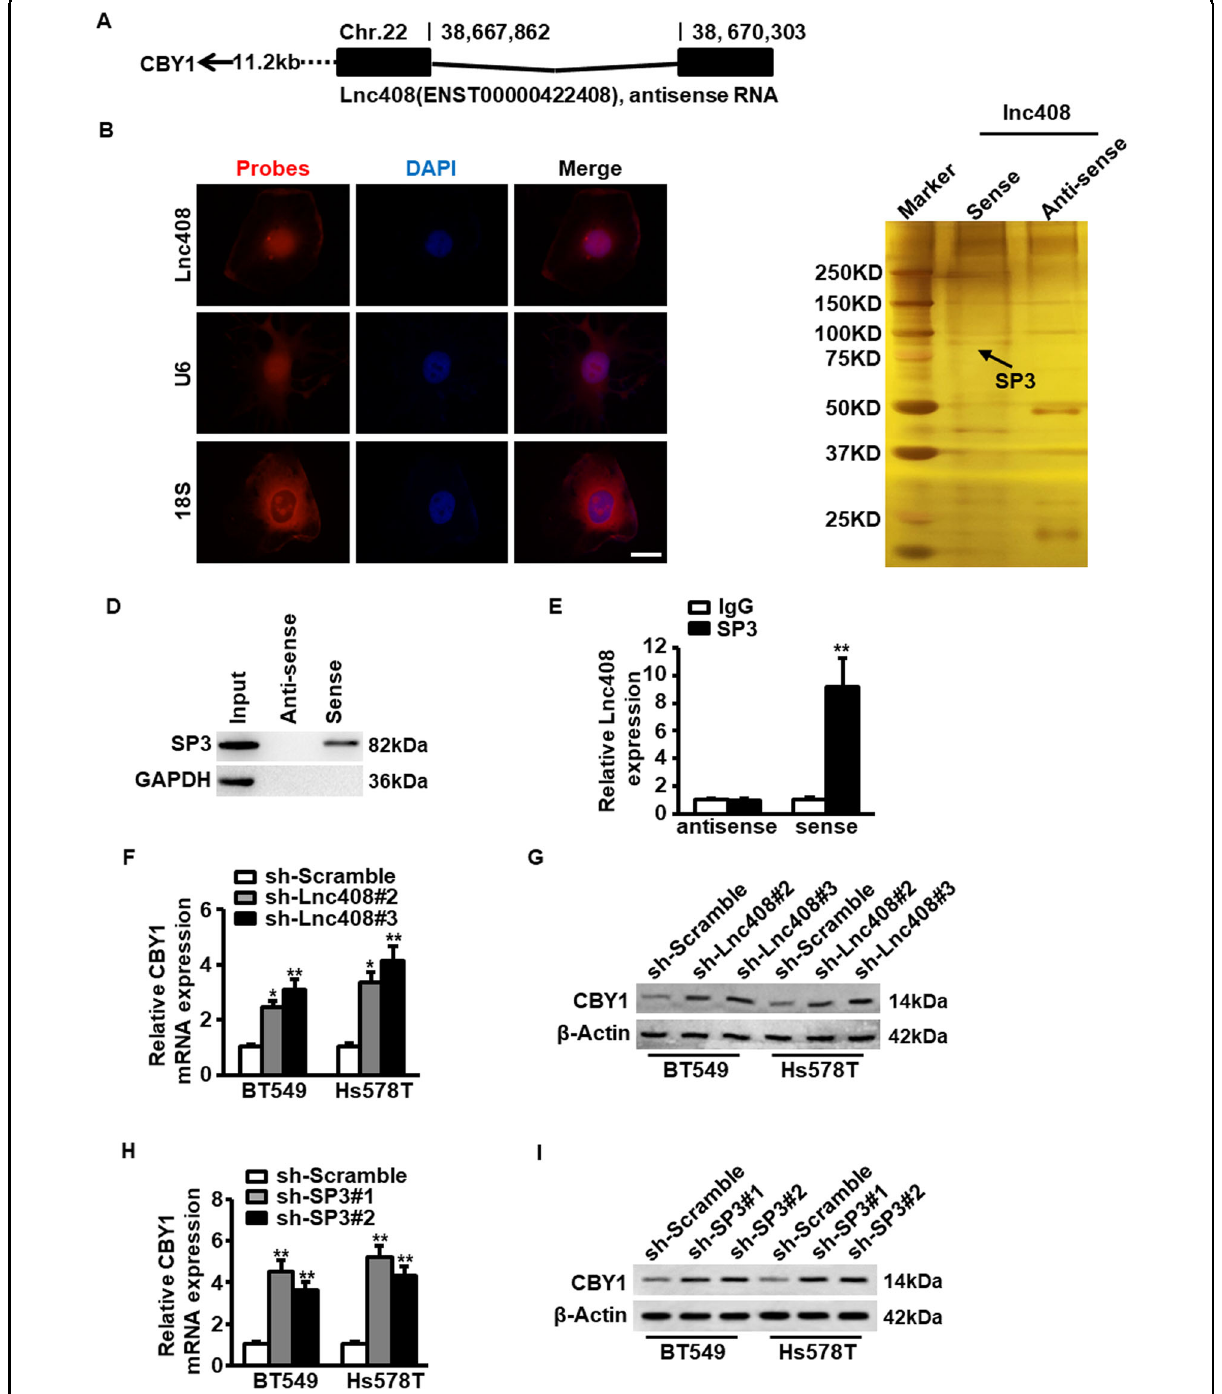
Fig. 4 Lnc408 regulates the expression of target gene CBY1. A Schematic annotation of lnc408 genomic locus on chromosome 22. Black rectangles represent exons. B Intracellular localization of lnc408 was visualized in BC cells by RNA-FISH assays. Representative images of lnc408 in BT549 cells are shown. U6 served as a nucleus control and 18S as a cytoplasm control; cell nuclei were counterstained with DAPI (scale bar, 10 μ m). C Full length of lnc408 transcripts (sense), antisense transcripts and control probe were labeled with biotin, then RNA-pull down was performed using nuclear extracts of mammospheres derived from BT549 cells. The interesting bands were followed by mass spectrometry. The arrow indicates the target of SP3. D The lnc408- binding protein SP3 in RNA-pull down precipitates (as carried out as in C , GAPDH as a negative control) was further con fi rmed by western blotting. E The interaction between lnc408 and SP3 was veri fi ed by an RNA immunoprecipitation (RIP) assay (** P <0.01). Data are shown as means±SD. F , G The mRNA or protein expression of CBY1 was determined by qRT-PCR ( F ) and western blotting ( G ) in lnc408-silenced BCSCs, respectively (* P <0.05, ** P <0.01). H , I The mRNA and protein expressions of CBY1 were determined by qRT-PCR ( H ) and western blotting ( I ) in SP3-knocked down BCSCs, respectively (** P